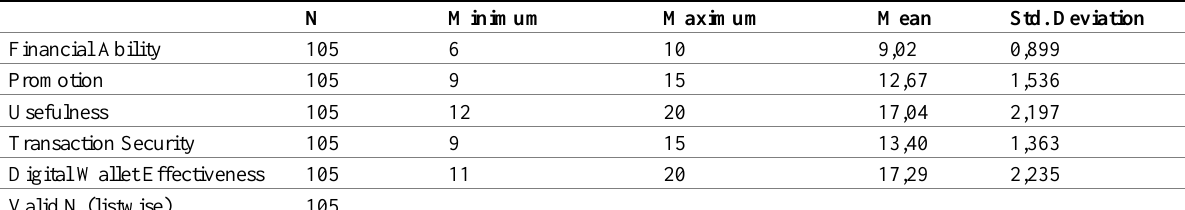
Table 1: Descriptive Statistics Test Results